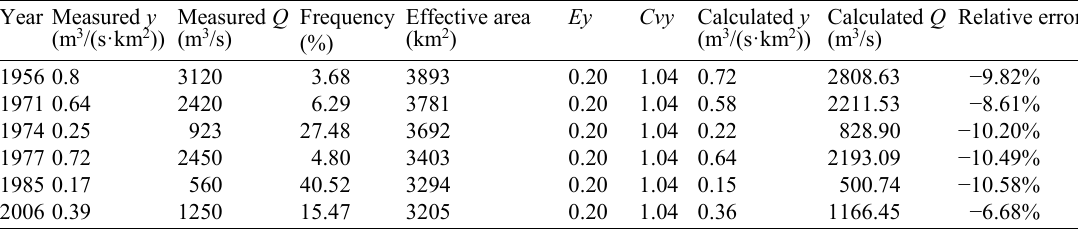
Table 1 Comparison between calculated and measured